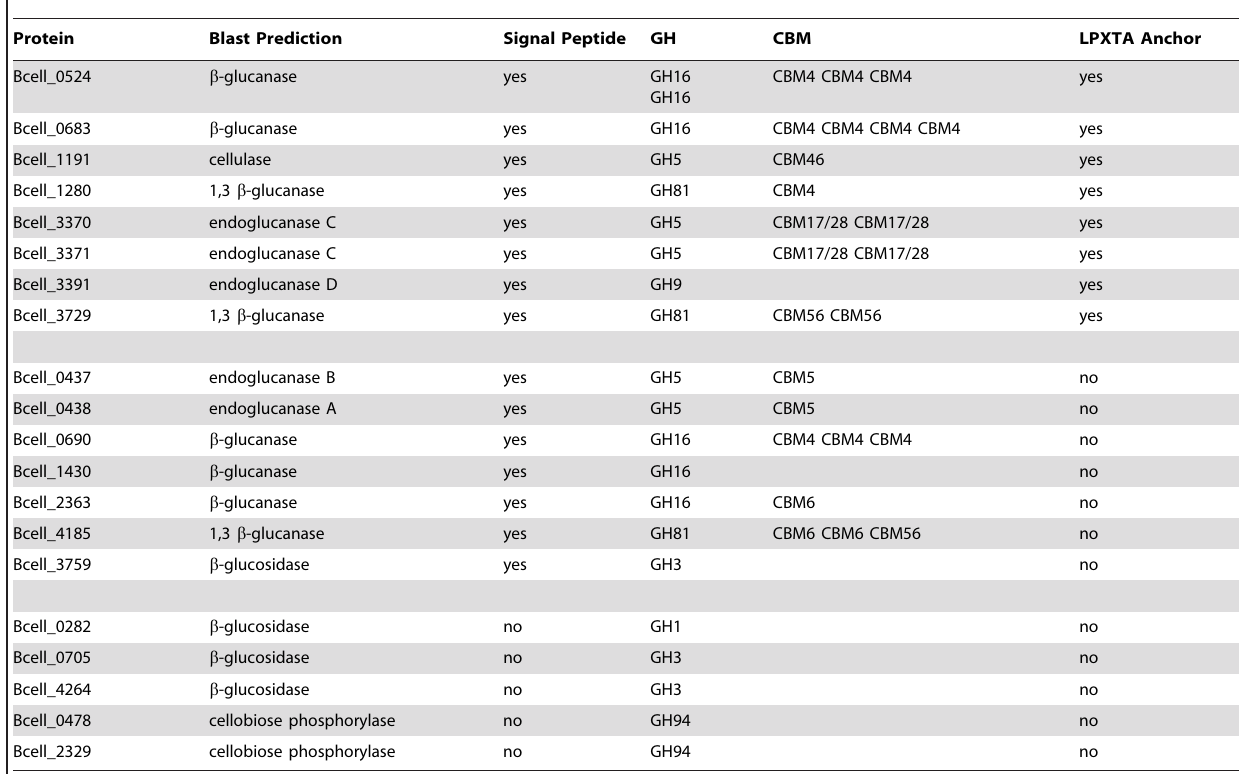
Table 4. Annotated Glucan-degrading Enzymes.